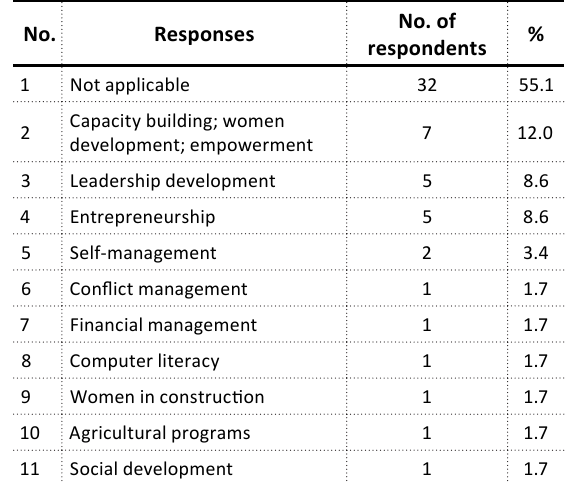
Table 8. Q1.1: If Yes, what is the nature of these programs – what do they aim to